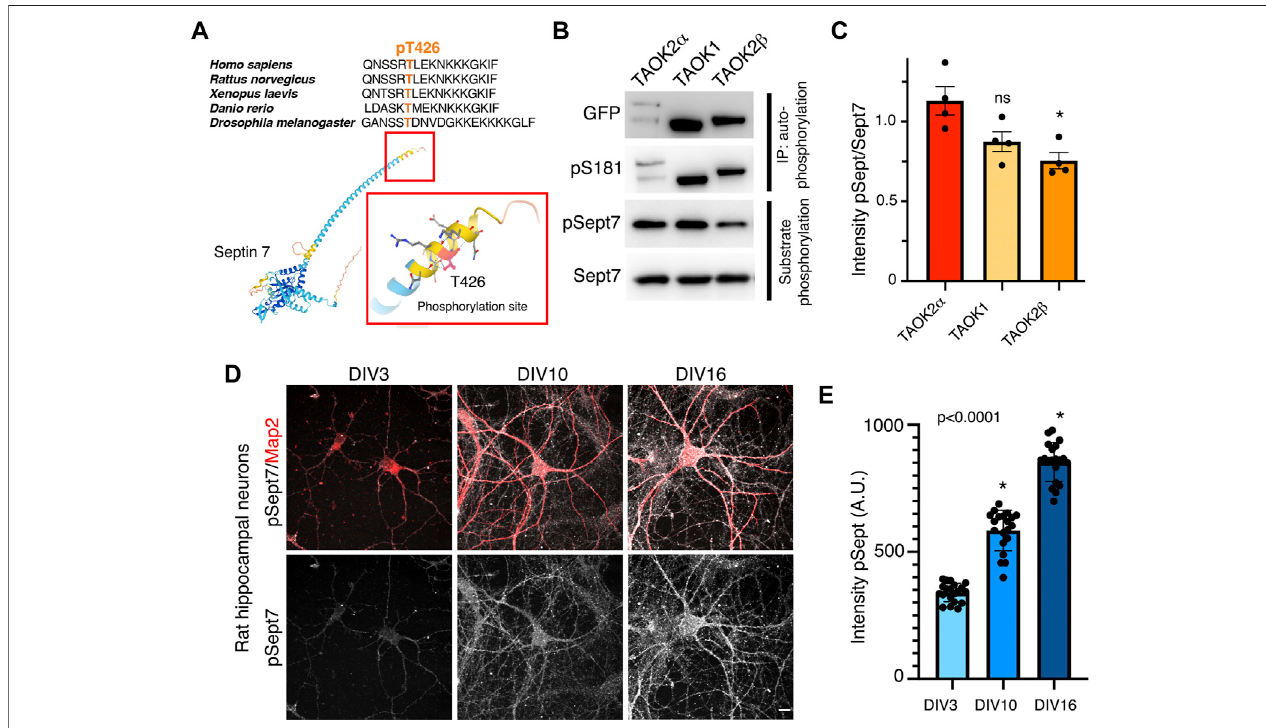
FIGURE 1 | TAO kinases phosphorylate the C-terminal tail of Sept7 during neuronal development. (A) Top: multiple sequence alignment of the C-terminal tail of Sept7 demonstrating its evolutionarily conserved sequence including the phosphorylation site. The phosphorylated residue T426 is shown in orange. Bottom: AlphaFold2.0 predicted protein structure of Sept7. Magni fi ed inset depicts the T426 phosphorylation site (red) in the C terminal tail of Sept7. (B) Western blot shows kinase activity of sfGFP-TAOK2 α , sfGFP-TAOK1, or sfGFP-TAOK2 β expressed in HEK293T cells, immunoprecipitated with GFP antibody, and incubated with puri fi edGST-Sept7C-terminaltail(321 – 438aminoacids)foran invitro kinasereaction.SubstratephosphorylationwasdeterminedbyprobingforphosphorylatedSept7 using the pT426 antibody. Total Sept7 was detected by antibody against GST tag. TAO kinase autophosphorylation was determined by probing for phosphorylated S181 residue. (C) Quanti fi cation of protein band intensity of Western blot in (B) . Bar graph displays the ratio of phosphorylated Sept7 band intensity to GST band intensity for each TAO kinase construct in which no signi fi cant difference was observed between TAOK2 α and TAOK1 kinases. Error bars represent standard error of mean from n = 4 experiments. (D) Rat hippocampal neurons at DIV3, 10, and 16 were fi xed and immunostained for endogenous phosphorylated Sept7 T426 and dendriticproteinMap2.Scalebarrepresents10 μ m. (E) Mean fl uorescenceintensityofphosphorylatedSept7T426atdistinctstagesofneuronaldevelopmentDIV3,10, and 16 are plotted. Error bars represent standard error of mean for n = 20 neurons from three different experiments. Dunnett ’ s multiple comparison shows signi fi cant changes in pSept7 levels between each